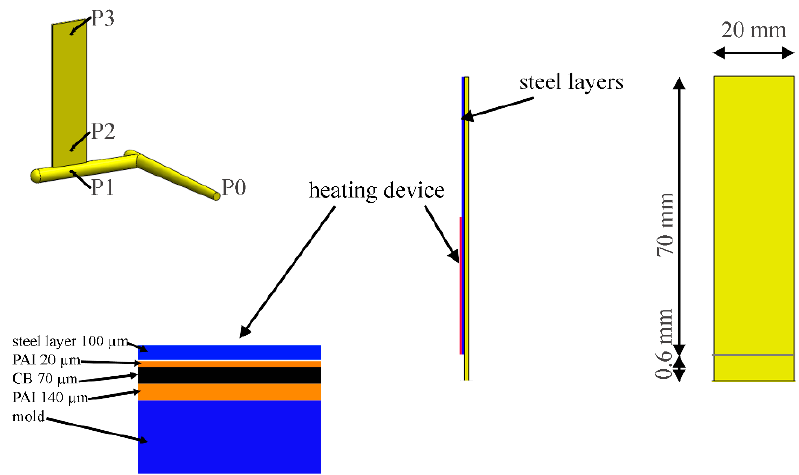
Figure 1. Sketch of the cavity geometry and of the heating device adopted. Positions P0 ÷ P3 where the pressure evolutions were measured during the injection molding tests are also indicated. (PAI = poly(amide-imide) insulating layer; CB = electrical conductive layer, made of carbon black loaded